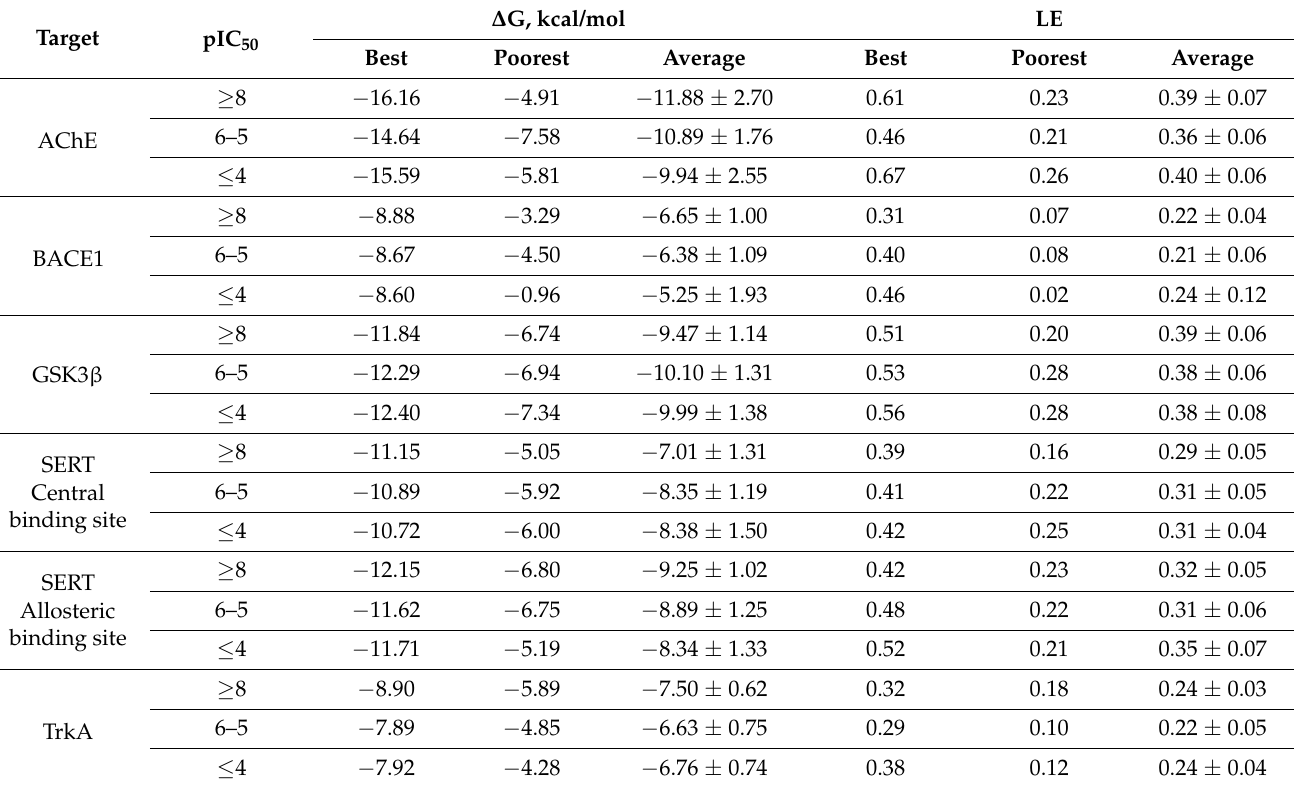
Table 2. The best (lowest binding energy), poorest (highest binding energy) and average values of calculated AutoDock 4.2.6 binding energies ( ∆ G, kcal/mol) and ligand efficiencies (LE). The average values of binding energies and LEs are presented as mean ± SD.